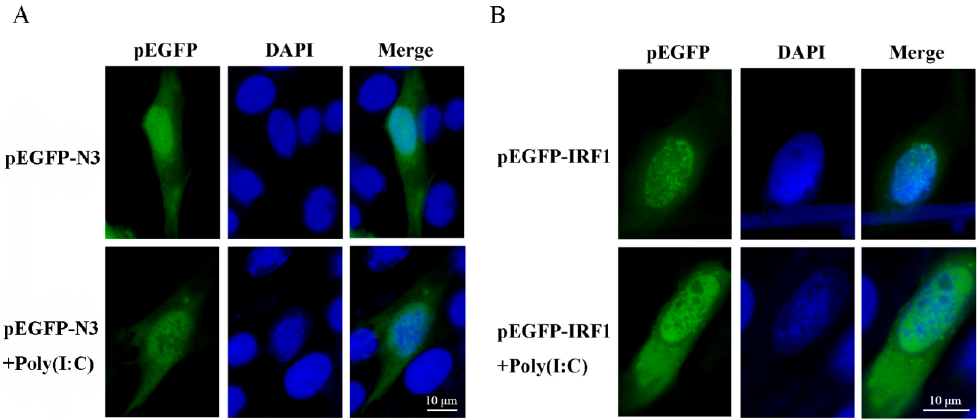
Figure 4. Subcellular localization of ToIRF1 in pompano cells. golden pompano snout tissue (GPS) cells seeded onto microscopy cover glass in six-well plates were transfected with 2 μ g of pEGFP-N3 or pEGFP-ToIRF1 plasmid, which were considered as the control ( A ) and experimental ( B ) group, respectively. After 24 h, the cells were stimulated with polyinosinic/polycytidylic acid (poly (I:C)) (5 μ g/mL) for 12 h, and then the cells were fixed and subjected to confocal microscopy analysis. Green staining represents the ToIRF1 protein signal ( B ), and blue staining indicates the nucleus region. All experiments were repeated at least three times, with similar results.